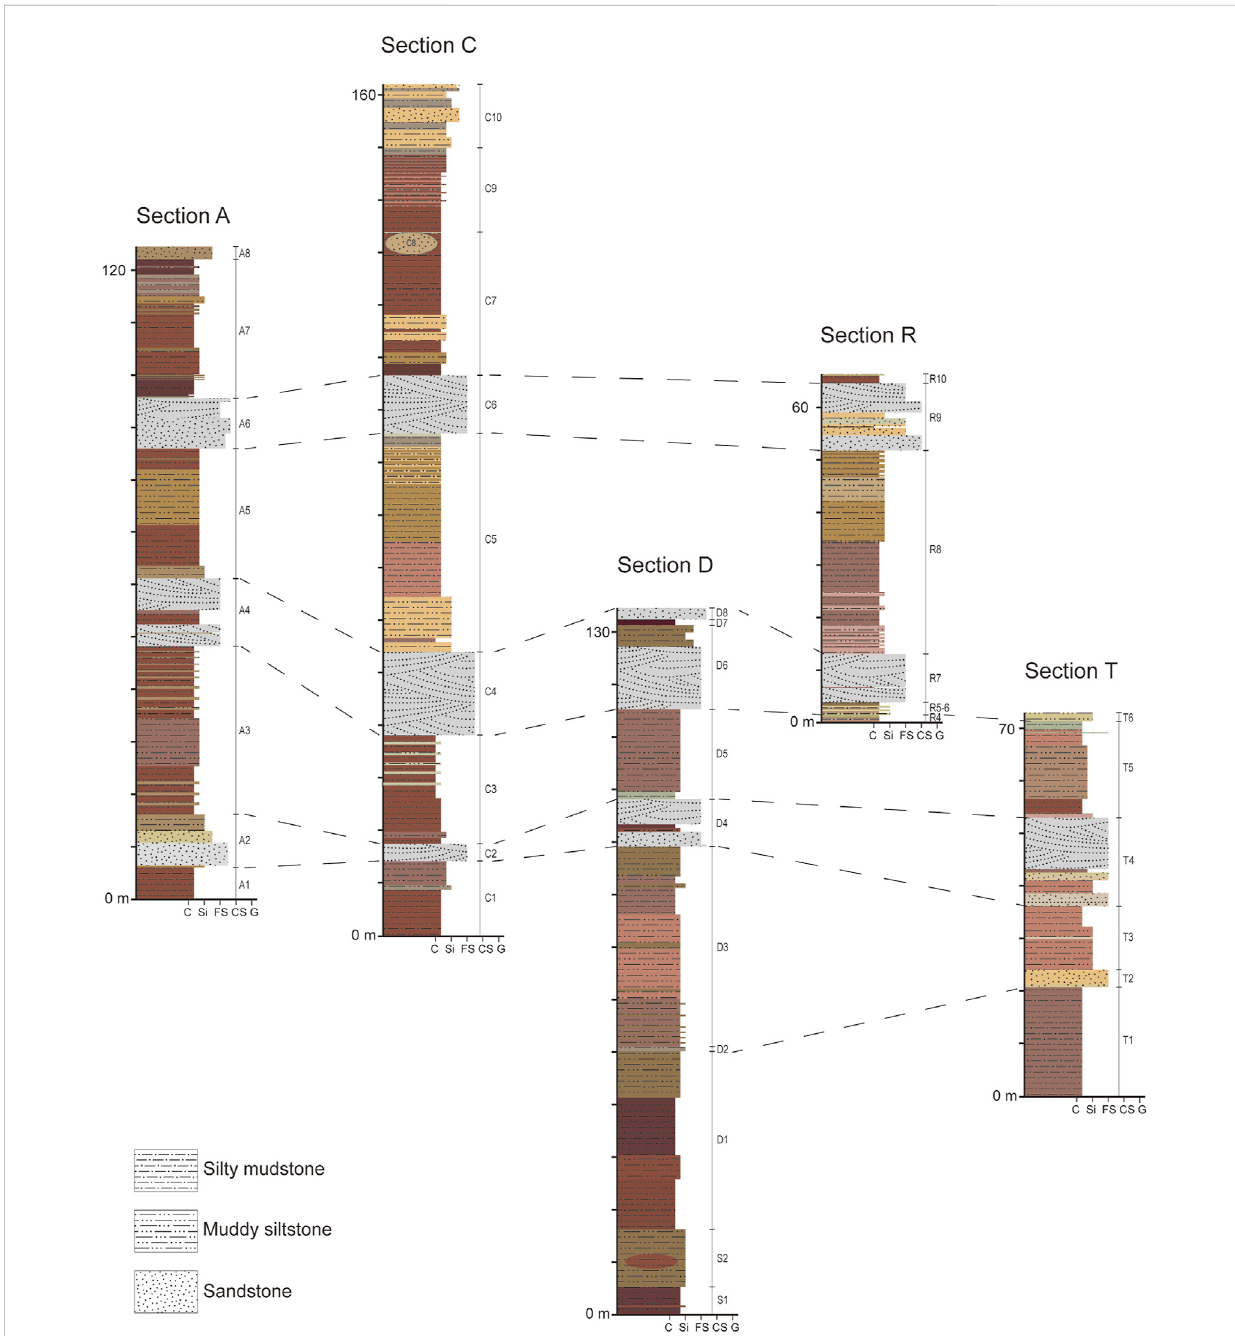
FIGURE 2 Stratigraphic columns of fi ve measured sections at Saint Jacques, showing the correlation of units in different sections. Grain-size scale: C = clay; Si = silt; FS = fi ne sand; CS = coarse sand; G = gravel.